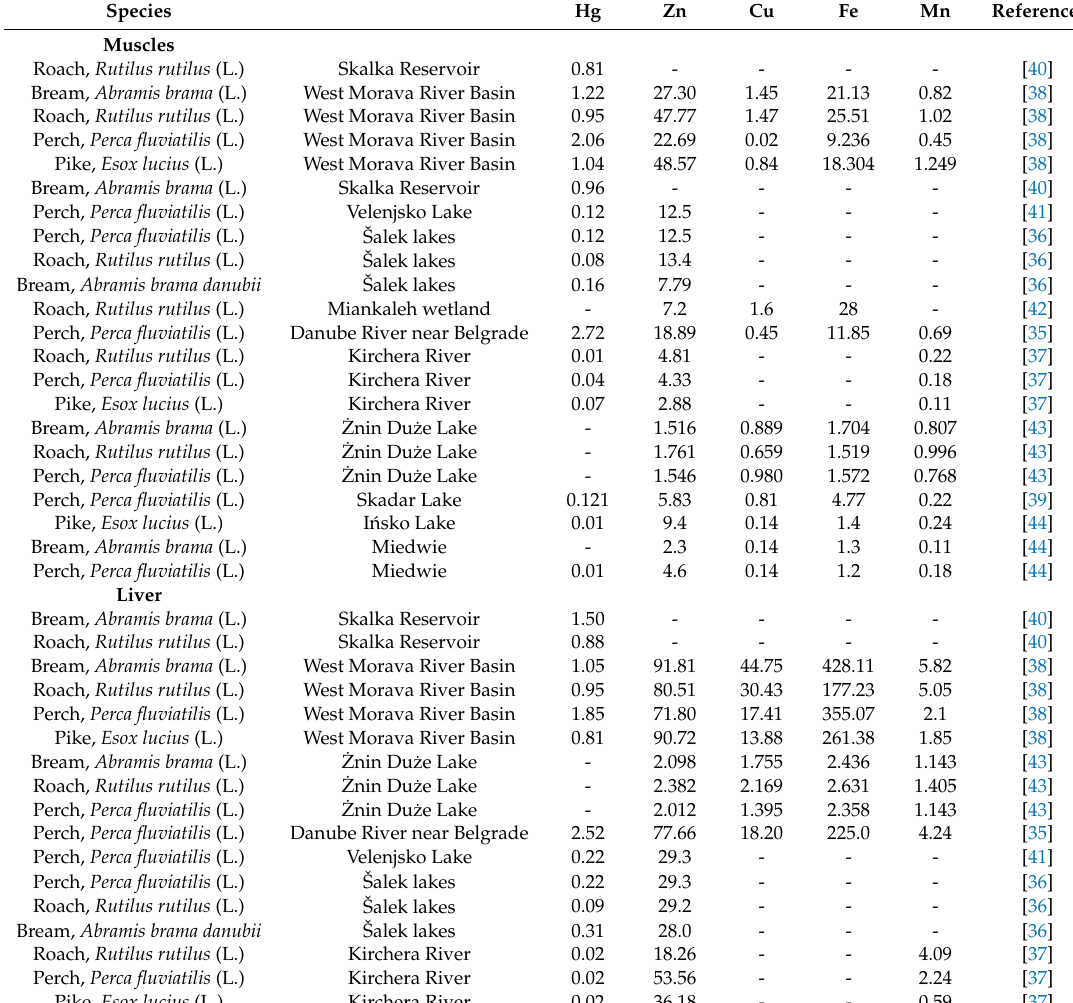
Table 2. The content of heavy metals in organs of freshwater fish (mg / kg wet weight). Species Hg Zn Cu Fe Mn Muscles Roach, Rutilus rutilus (L.)